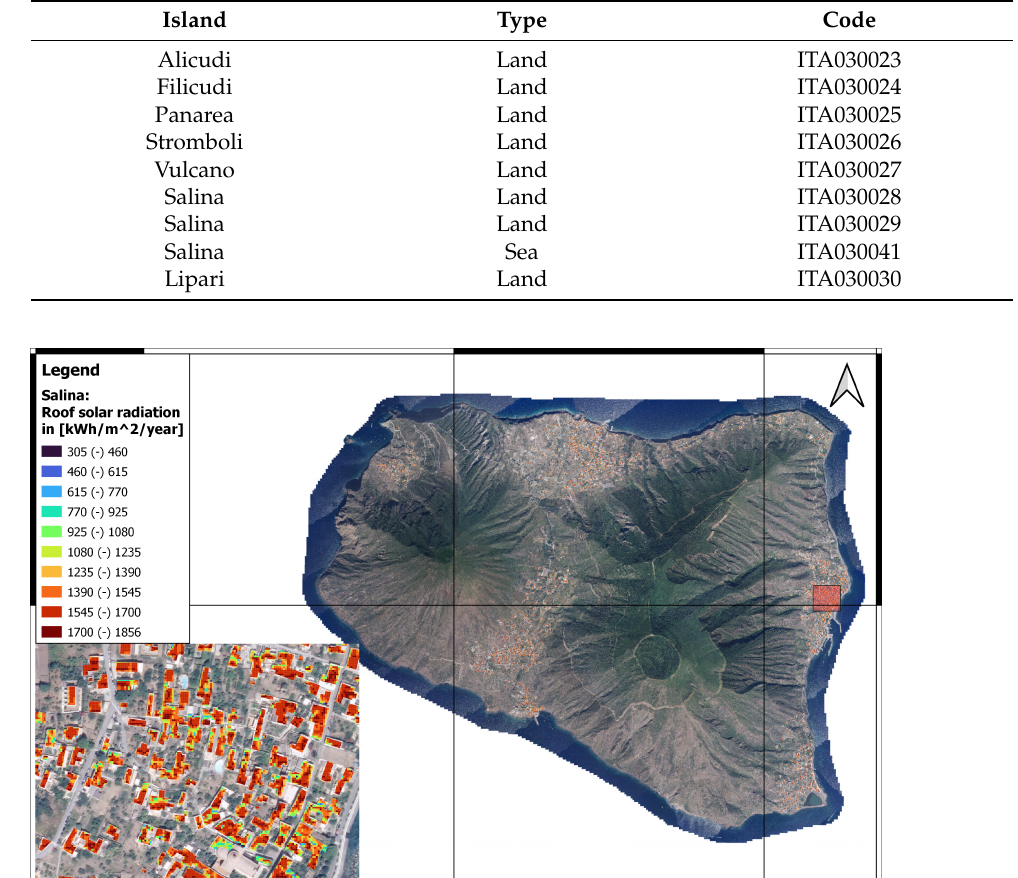
Table 7. SCI Areas on Eolian Archipelago.